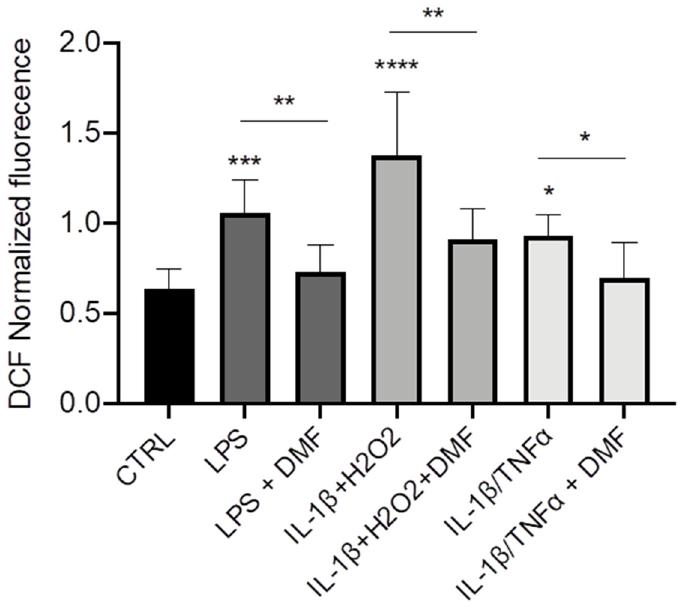
Figure 5. Co-treatment with DMF reduced the reactive oxygen species (ROS) production in CFBE. Measurement of ROS concentration in CFBE stimulated by 10 µg/mL of LPS; 30 ng/mL IL-1 β + 100 µM H 2 O 2 or 30 ng/mL IL-1 β + 30 ng/mL TNF- α in presence or absence of 50 µM DMF for 24 h ( n = 8). * p < 0.05; ** p < 0.01; *** p < 0.001; **** p < 0.0001.